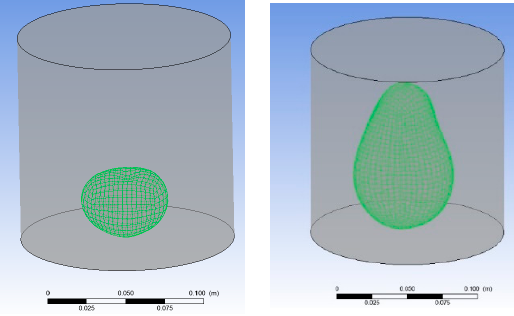
Figure 7. CFD setup for the 0-D validation cases. Single units of tomato (left) and avocado (right) are placed in cylindrical containers and simulated for six days of storage time to establish respiration coefficients required for the REV simulations.